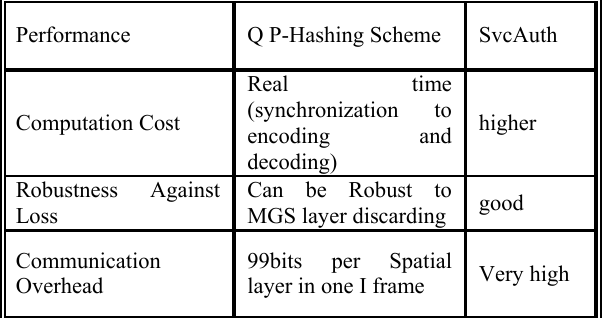
Table 4. Comparison measure